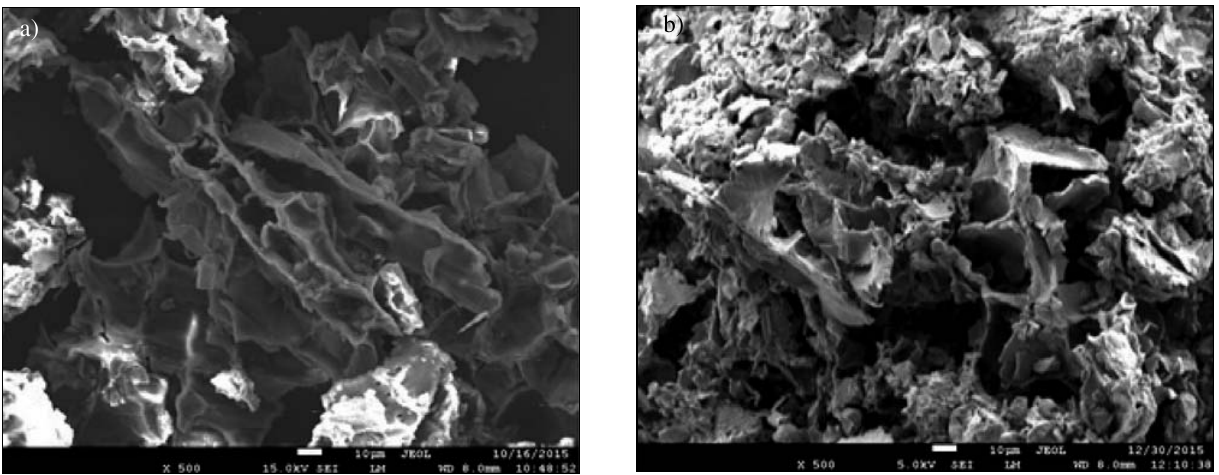
Figure 6. SEM pictures of sweetgum bark samples a) before the sorption of 2,4-DCP b) after the sorption of